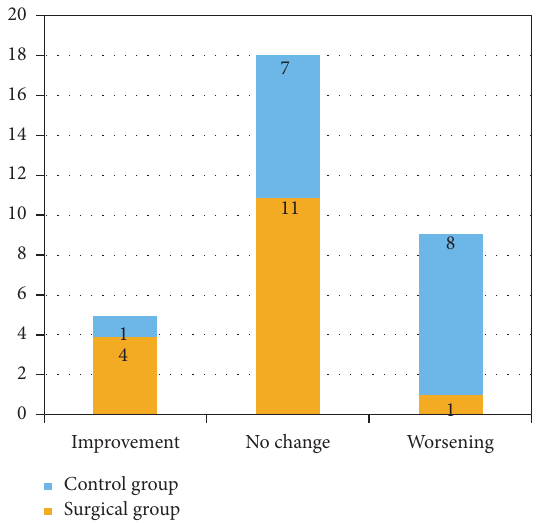
Figure 1: Distribution of T25FW variability across the two